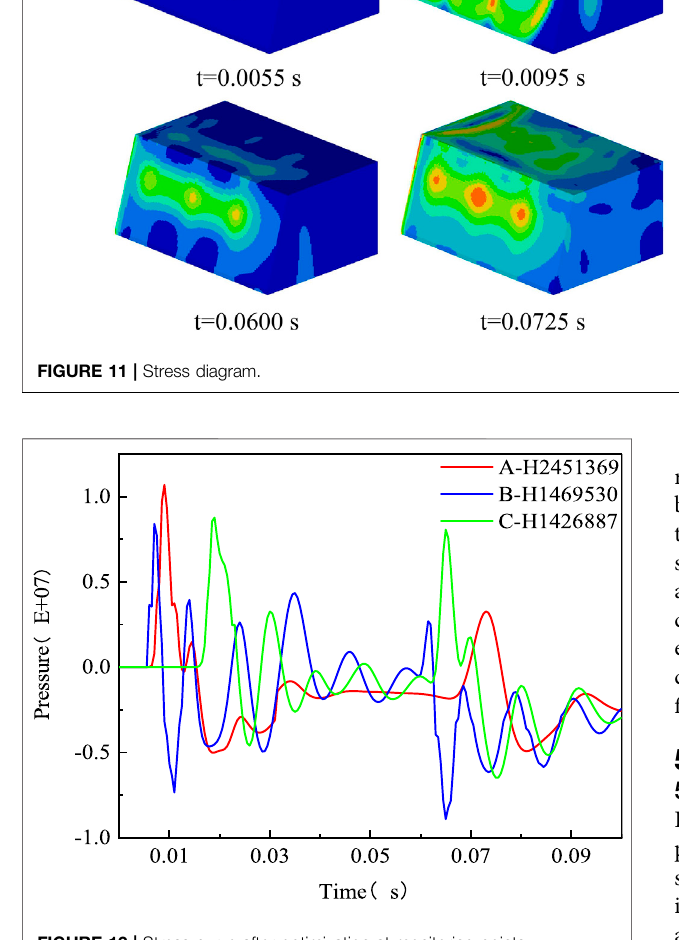
FIGURE 12 | Stress curve after optimization at monitoring